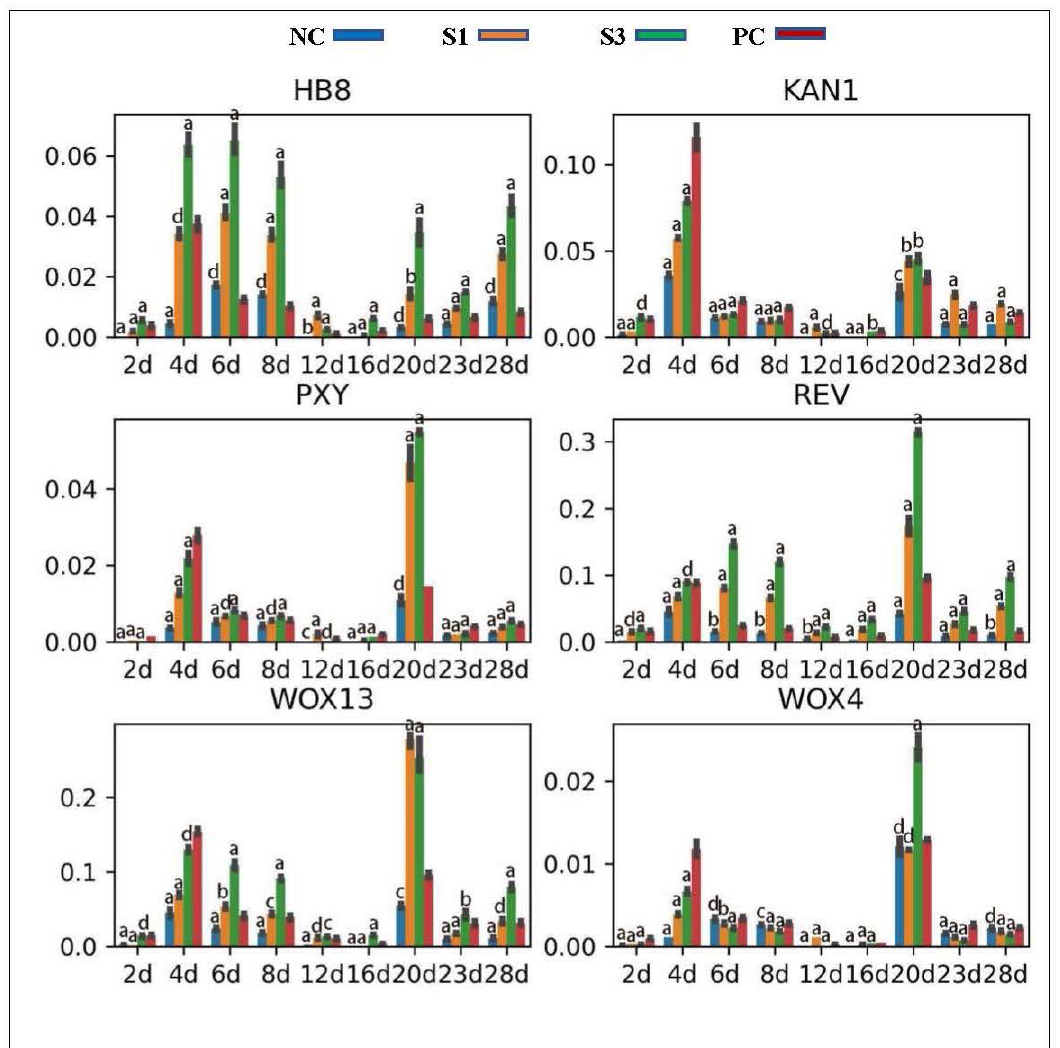
Figure 8. Expression profiles of genetic regulators in differently treated samples. a, p -value < 0.001; b, p -value < 0.01; c, p -value < 0.05; d, p -value > 0.05.